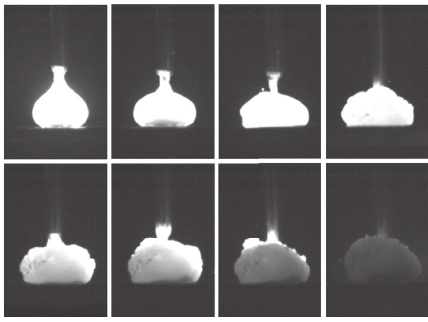
Figure 12: Droplet spreading process (wire feed speed is 5.0m/min).